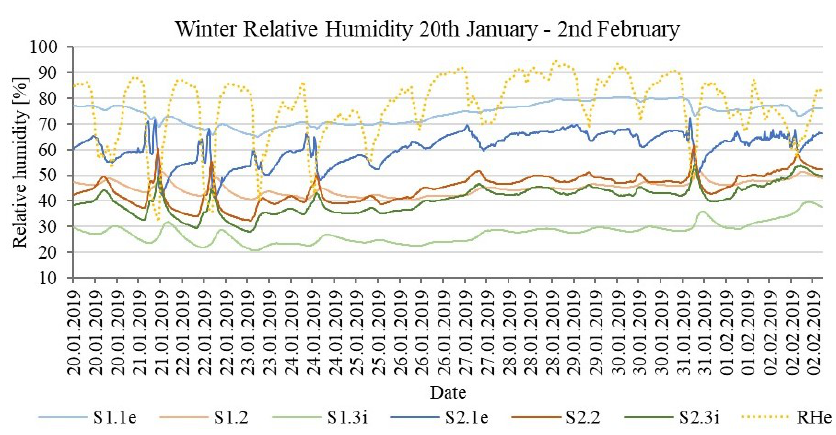
Figure 5. Comparison of the relative humidity in the winter